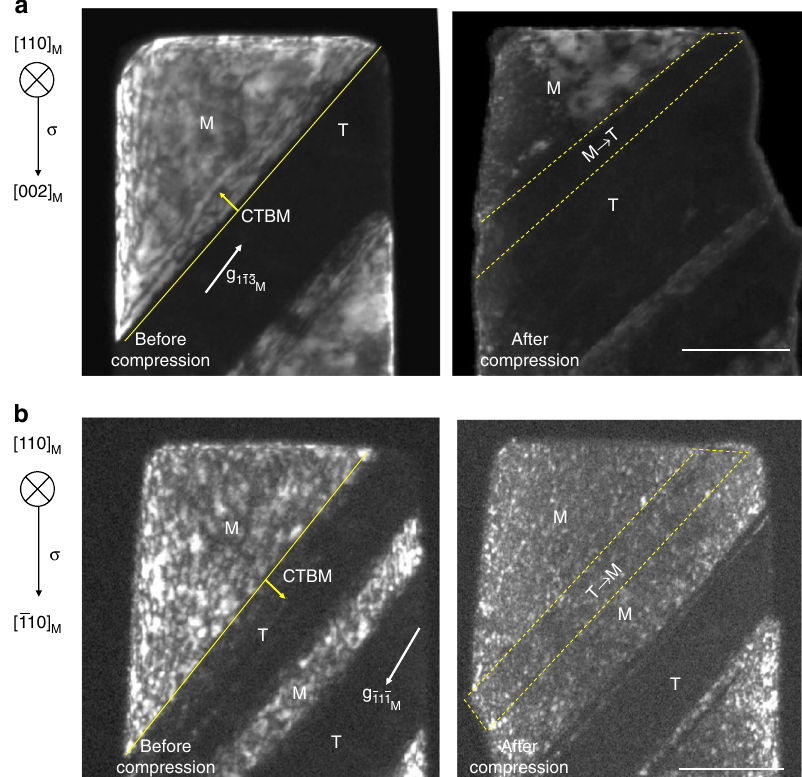
oriented Cu nanopillar. The scale bar in each M